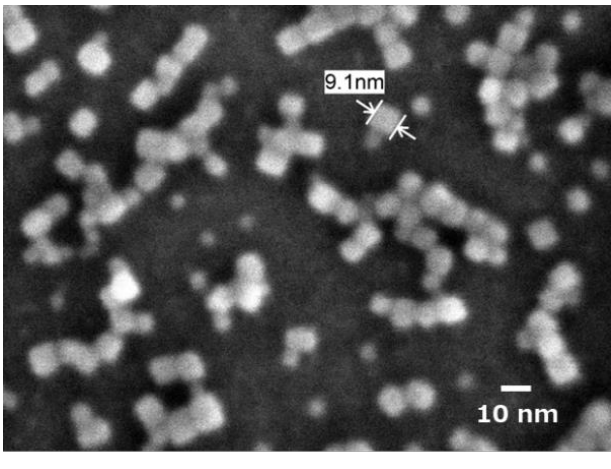
Figure 4. Low-voltage high spatial resolution imaging.